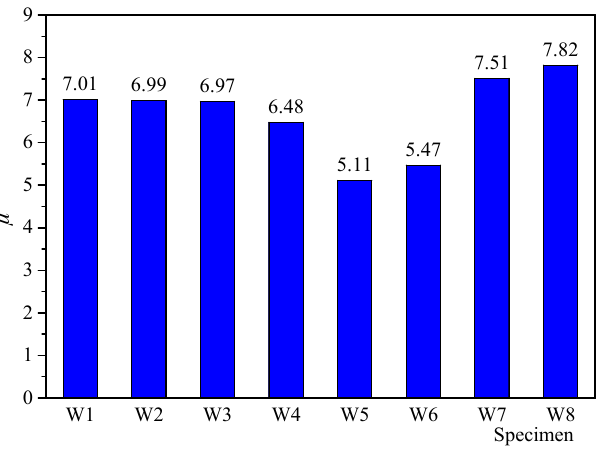
Figure 14. Ductility ratio μ of specimens.